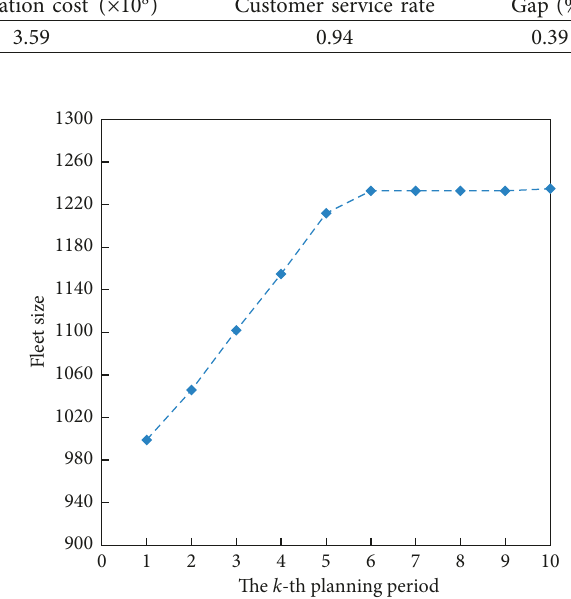
Figure 17: Fleet size at each planning